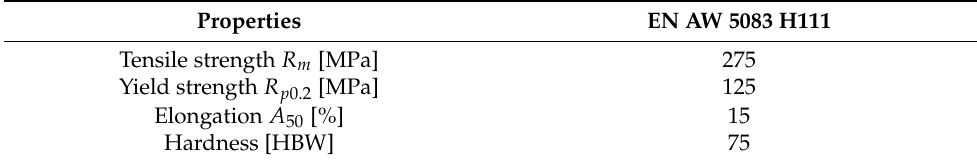
Table 2. Mechanical properties of EN AW 5083 by DIN EN 485-2 [11].